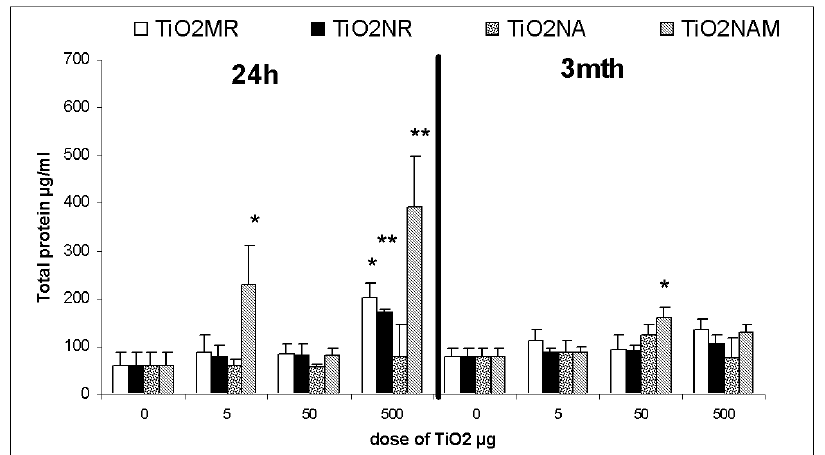
FIGURE 9. TiO - total protein in BALF. The levels of total protein in BALF 2 are shown as the median and 75 th percentile for micro-size rutile (MR - white), nano-size rutile (NR - black), nano-size anatase (NA - dotted), and nano-size amorphous (NAM - dashed). BALF was collected 24 h or 3 months postinstillation in BALB/c mice. For explanation of statistical test results (* and **), see Statistics. Each group contained eight